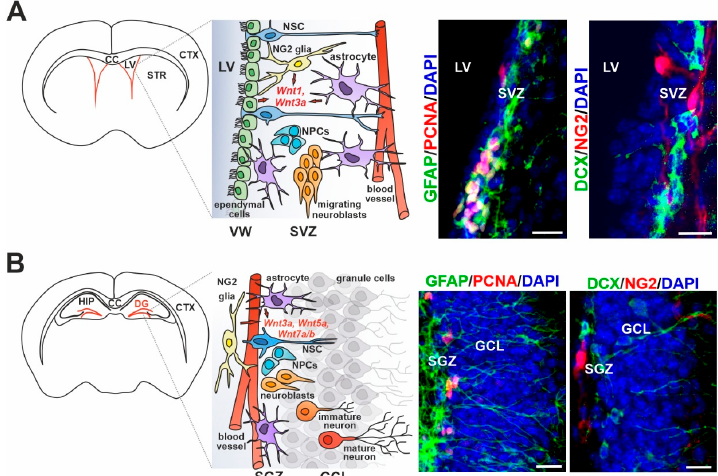
Figure 2. Neurogenic niches of the adult mammalian brain. Schematic diagrams illustrating the main cellular components within the neurogenic niche in the ( A ) subventricular zone (SVZ) of the lateral ventricles (LVs) and ( B ) dentate gyrus (DG) of the hippocampus (HIP) containing the neurogenic niche in the subgranular zone (SGZ), and representative immunofluorescence images of the corresponding regions showing the main markers of cell types indicated in the illustrated schemes. The neuronal lineage in both compartments is represented by neural stem cells (NSCs), neural progenitor cells (NPCs) and migrating neuroblasts. In addition, neuronal maturation is shown in the granule cell layer (GCL) adjacent to the SGZ. Glial cells, represented by astrocytes and neuron-glial antigen 2 (NG2)-positive glia in both regions, and by ependymal cells constituting the ventricular wall (VW) of the LVs, release Wnt ligands (in red color) in order to activate quiescent NSCs and mediate their proliferation/differentiation. Glial fibrillary acidic protein (GFAP) represents NSCs and a subpopulation of astrocytes; proliferating cell nuclear antigen (PCNA) marks proliferating progenitors; doublecortin (DCX)-positive cells identify both neuroblasts and immature neurons; NG2 is present in NG2 glia; 4 ′ ,6-diamidino-2-phenylindole (DAPI) stains cell nuclei. Note that the magnified field and DG histology in panel B are rotated approximately 90° counterclockwise compared to the scheme of the frontal section. Scale bar: 15 µm. Abbreviations: CC, corpus callosum; CTX, cortex; STR, striatum.